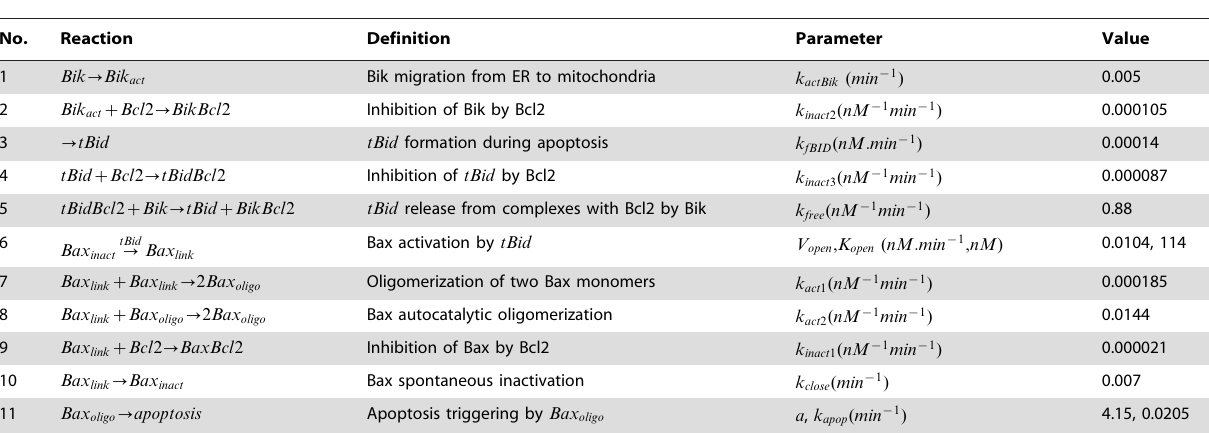
Table 2. Parameters values for the apoptosis model.